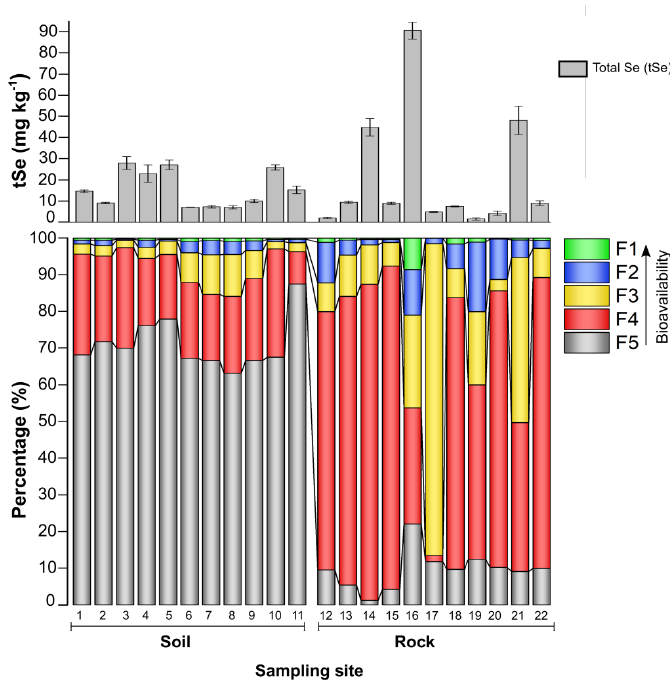
Figure 2. Total selenium concentrations and proportions of Se in the five operationally defined Se fractions in soil and rock samples across the study area. The bars show means ± sd (n = 3). F1: water-soluble Se, F2: Exchangeable Se, F3: Alkali-soluble Se, F4: Acid-soluble Se, and F5: Residual Table 1. The concentration of tSe in rocks, soils, and pH and TOC, as well as tSe in maize organs and biomasses (dry weight per plant). Sample Parameter